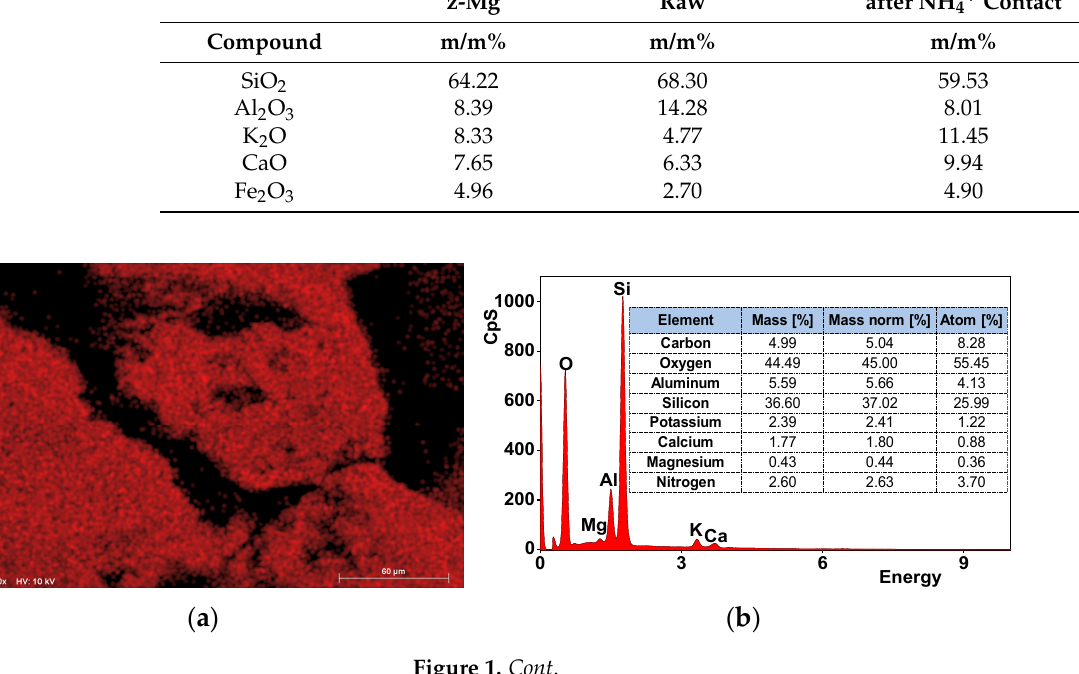
Table 2. XRF characteristic results for activated (z-Mg), raw zeolites and after ammonium contact. Compound m/m% z-Mg Raw